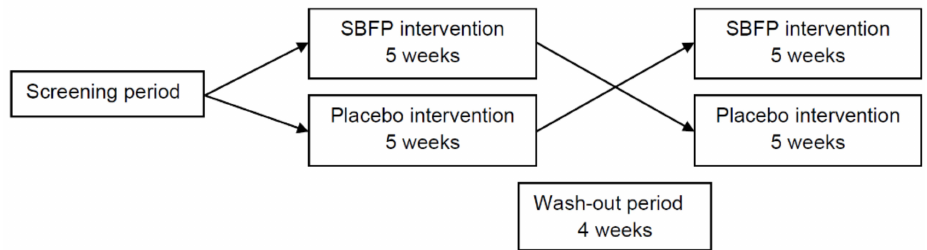
Figure 1. Two-stage and randomized crossover design of this study. SBFP, sea-buckthorn fruit puree.